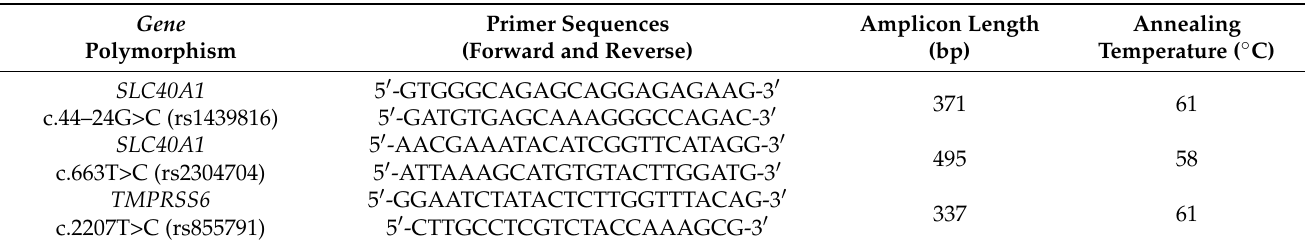
Table 1. The list of primer sequences and annealing temperatures for PCR and sequencing used for detecting the studied